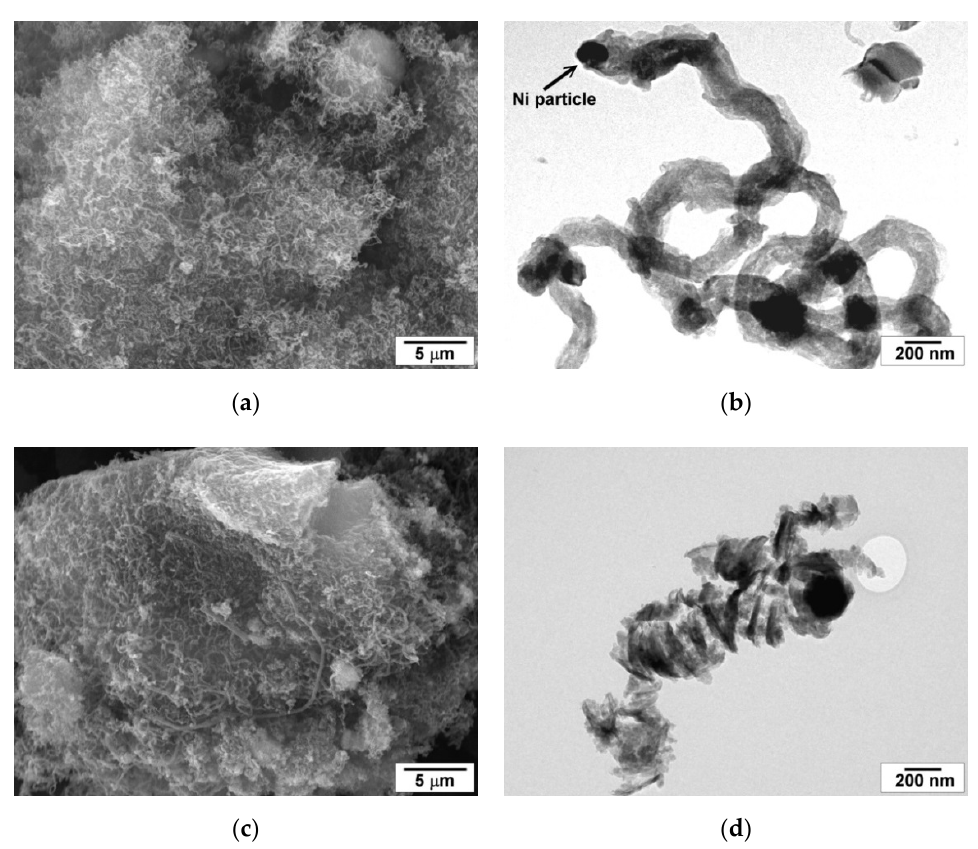
Figure 8. ( a ), ( b ) SEM and ( c ), ( d ) TEM images of the nanostructured carbon material produced via the processing of C 2 H 4 Cl 2 over Ni/Al 2 O 3 at 550 °C: ( a ), ( c ) without addition of H 2 ; ( b ), ( d ) in the presence of H 2 (40 vol%).